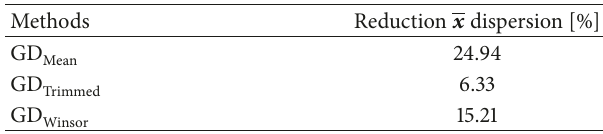
Table 48: Contaminated 𝜒 2 with 100 points.